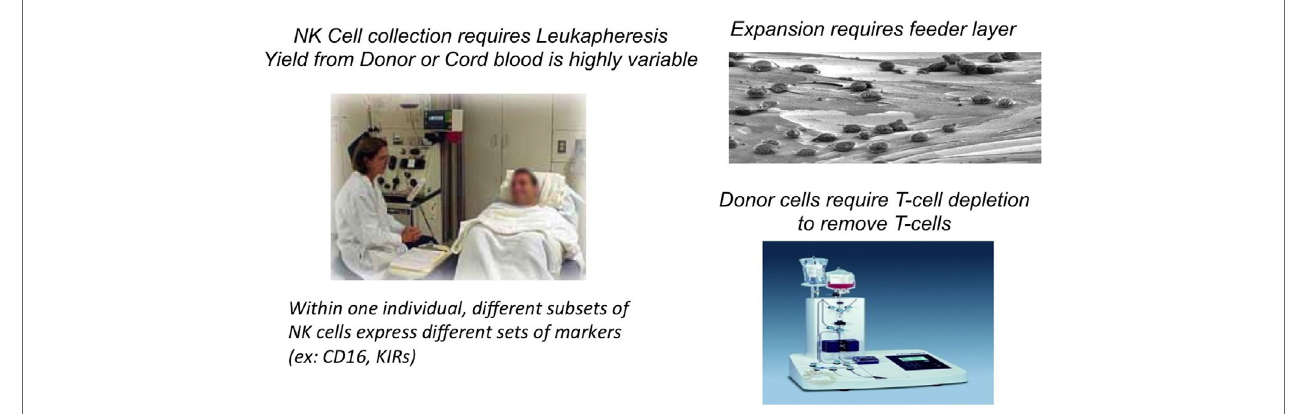
FiGURe 1 | Biologistic challenges of obtaining blood NK cells for cell therapy